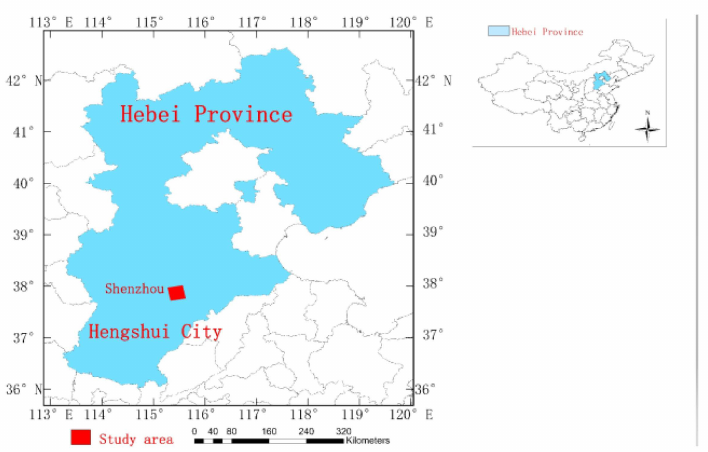
Figure 1. Location of the experimentation